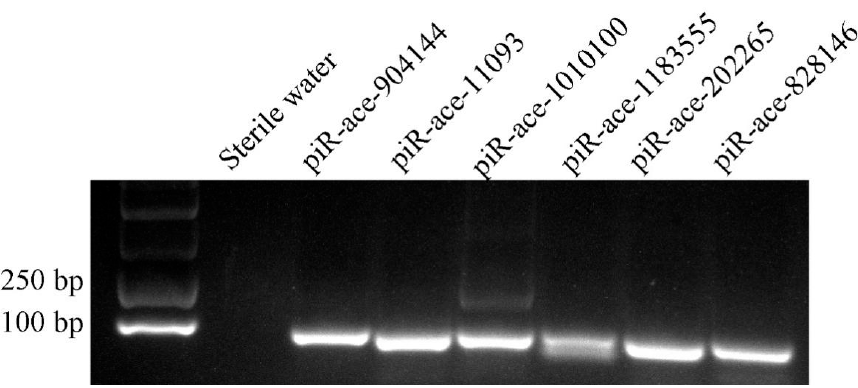
Figure 7. Stem-loop RT-PCR validation of six A. c. cerana DEpiRNAs. Further, the RT-qPCR result suggested that the expression trends of these six DEpiRNAs were consistent with those in the transcriptome datasets, confirming the au- thenticity and reliability of our sequencing data (Figure 8).